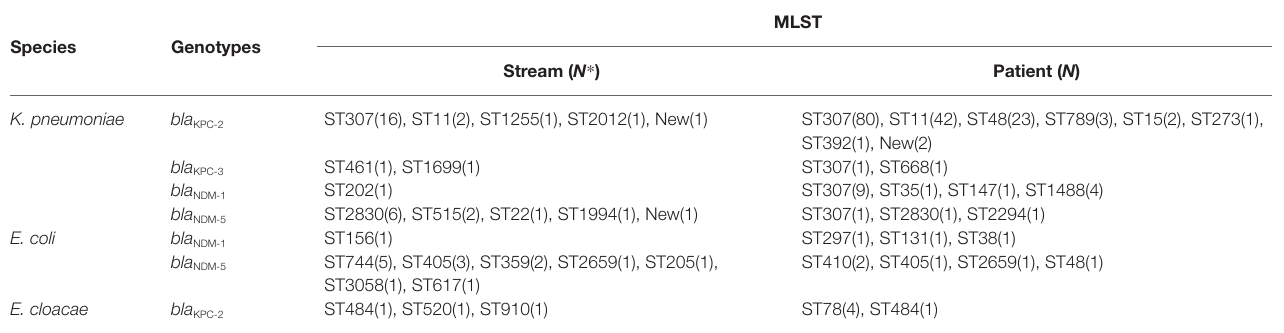
TABLE 4 | Multi-locus sequence typing of carbapenemase-producing Klebsiella pneumoniae , Escherichia coli , and Enterobacter cloacae strains from streams and patients.